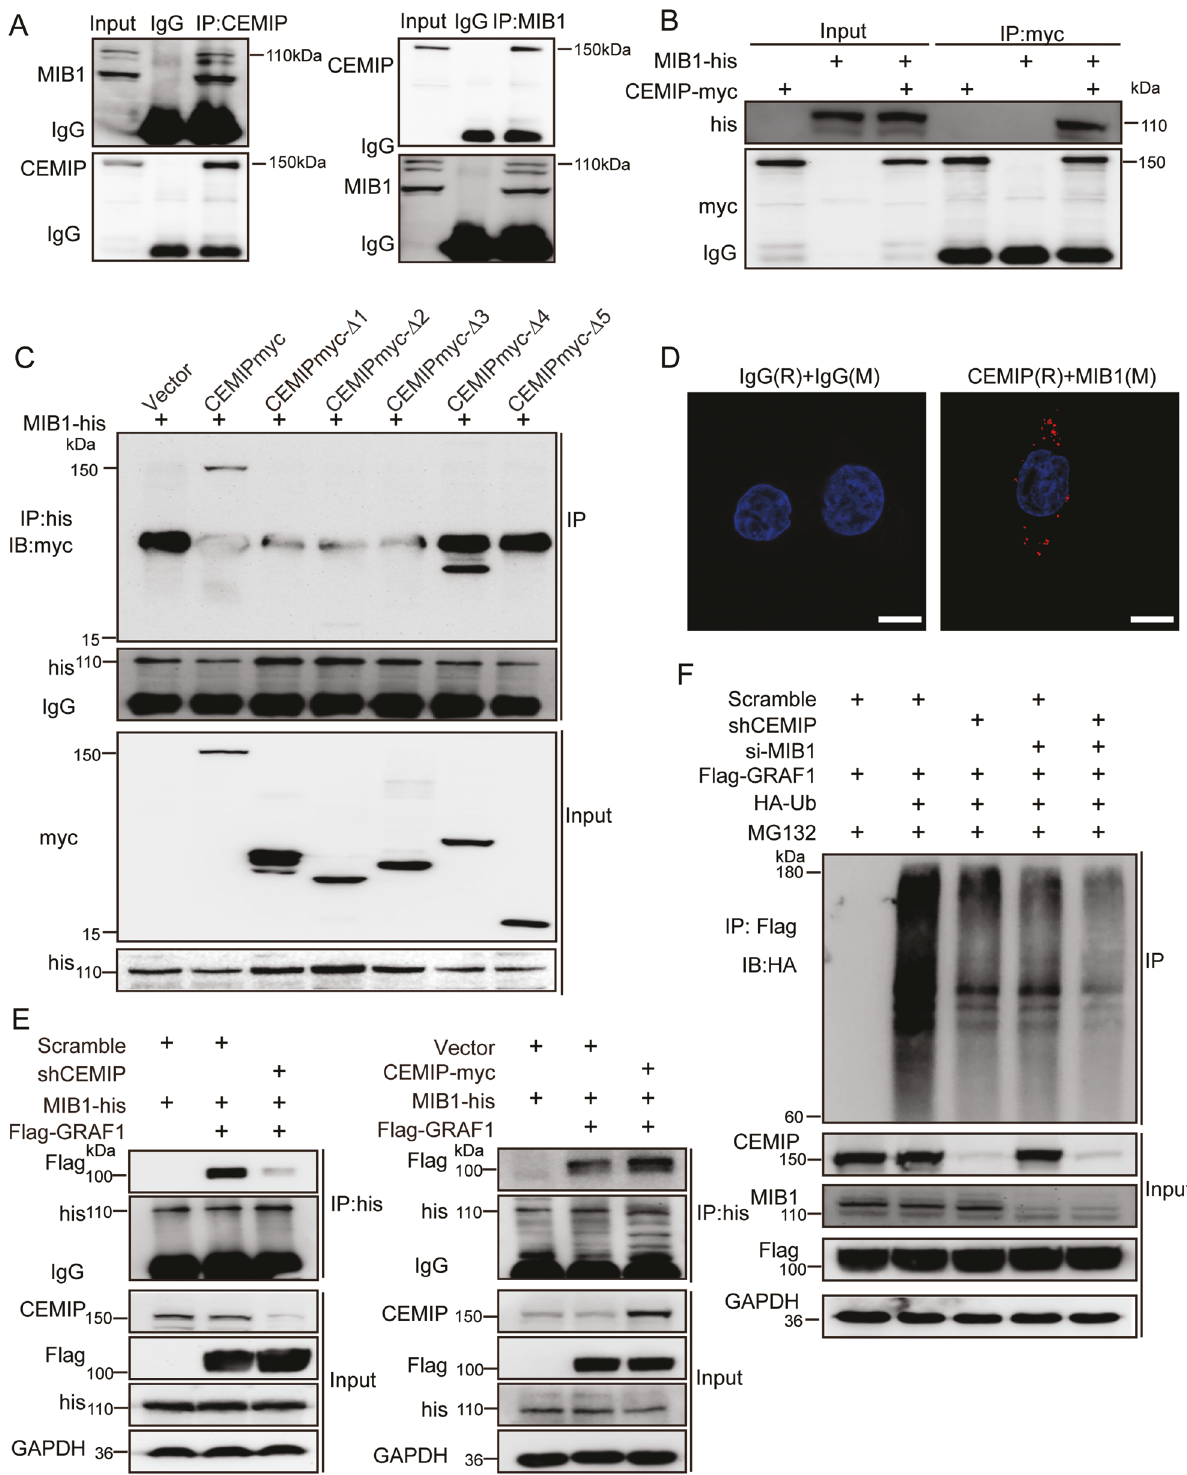
Fig. 4 CEMIP acts as a scaffold protein in bridging GRAF1 and MIB1 which is critical to GRAF1 degradation. A The interactions between endogenous CEMIP and endogenous MIB1 were detected by Co-IP in HCT116 cells. Rabbit IgG was used as a negative control. B The interaction between exogenous CEMIP and exogenous MIB1 was detected by Co-IP in HEK293T cells. C The interactions between exogenous CEMIP deletion mutants and exogenous MIB1 were detected by Co-IP in HEK293T cells transfected with the indicated constructs. D The interaction between endogenous CEMIP and MIB1 was further con fi rmed by the PLA assay in HCT116 cells. Scale bar, 10 μ m. E Western blotting analysis of proteins derived from Co-IP in HCT116 (left) and SW480 cells (right) transfected with the indicated plasmids. F Western blotting analysis of the ubiquitination level of GRAF1 derived from Co-IP in HCT116 cells transfected with the indicated constructs.